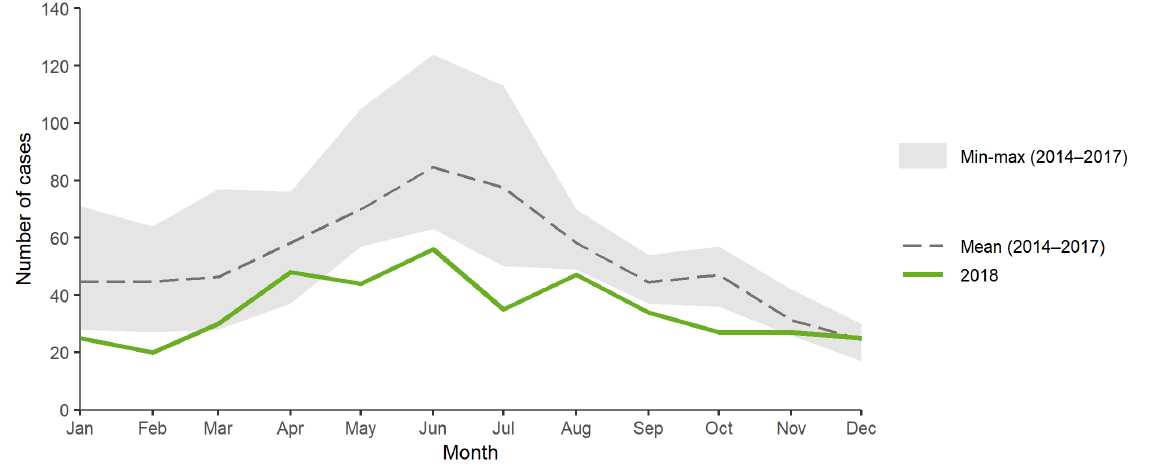
Figure 3. Distribution of confirmed Q fever cases by month, EU/EEA, 2018 and